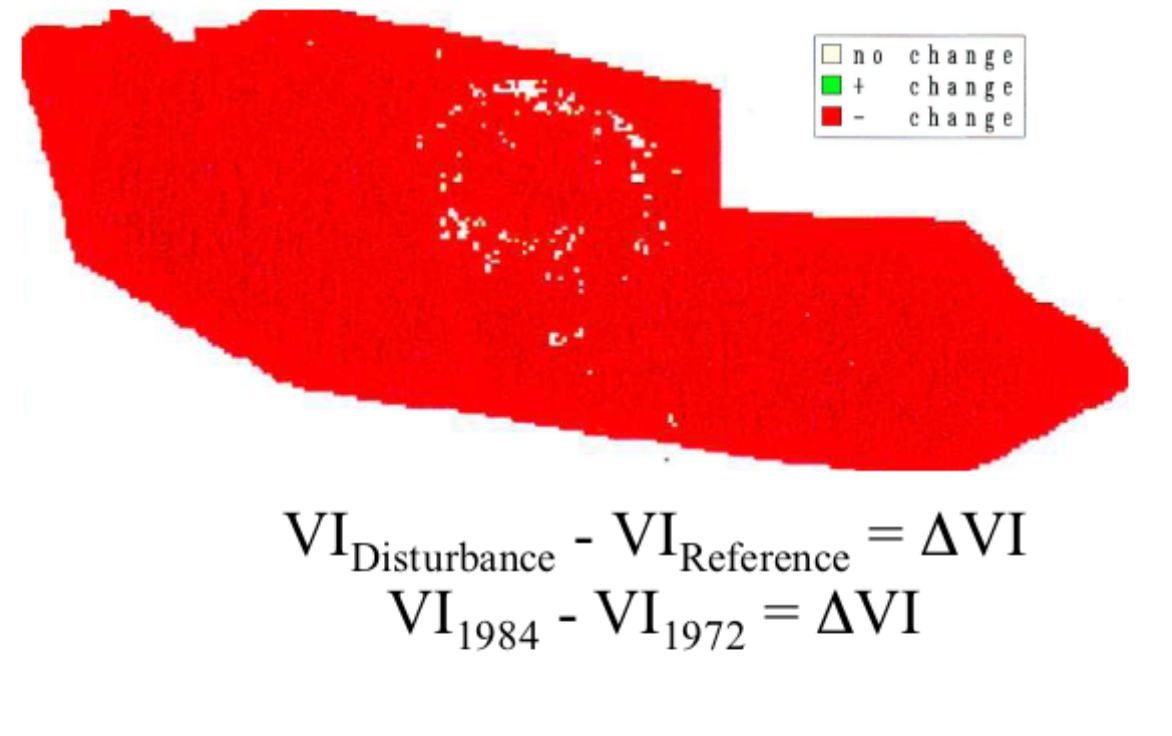
Fig. 4. Map of the magnitude of change in amplitude after a disturbance. Image differencing is a spatially explicit method to visualize change in a landscape. The subtraction of the vegetation index (VI) reference year (initial conditions in 1972) from the disturbance year (the 1984 drought) is a measure of amplitude. The white areas that did not change are located in bofedal (wet meadow) areas of the study